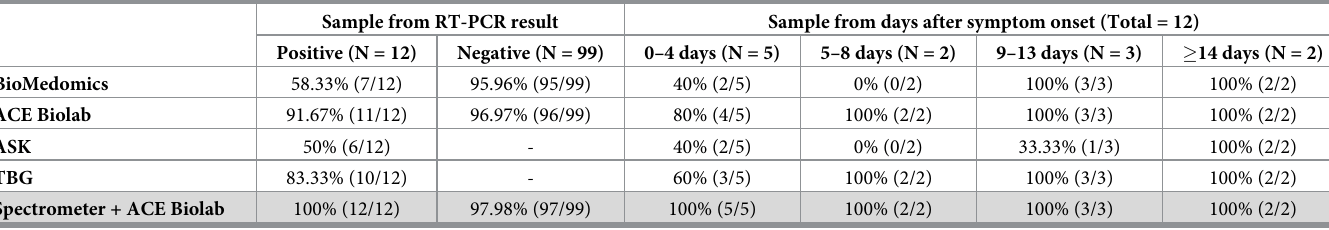
Table 3. The performance of 5 types of lateral flow